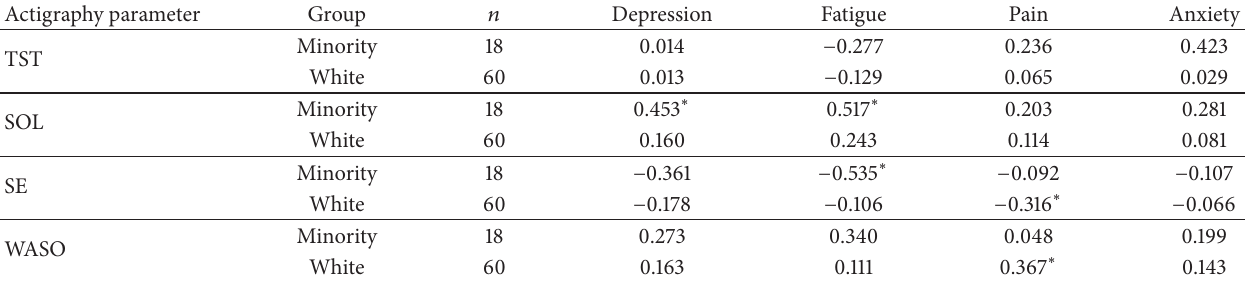
Table 4: Correlations between sleep actigraphy parameters and depression, fatigue, pain, and anxiety ( 𝑁 = 78 ).